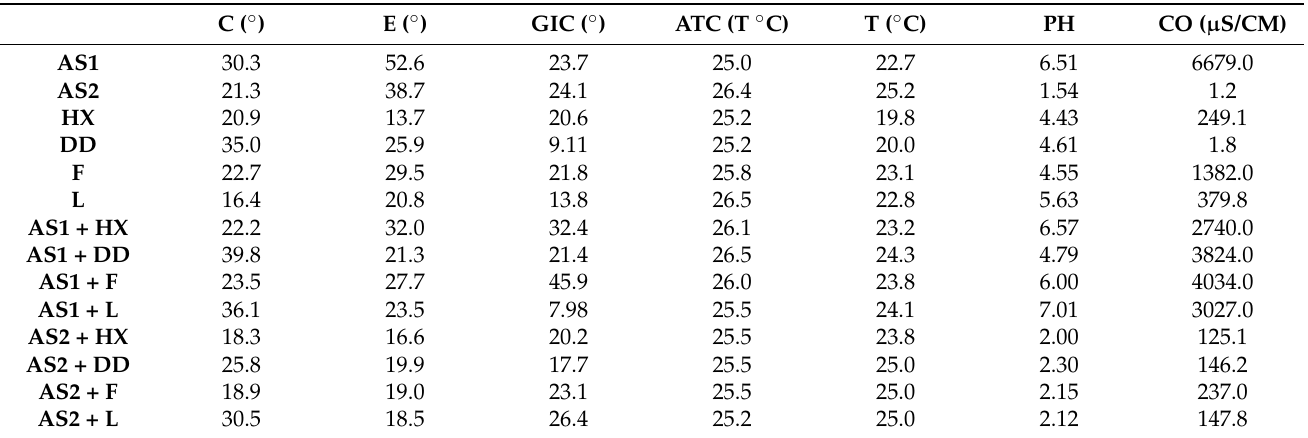
Table 2. Contact angles, automatic temperature compensation within the conductivity measurement canal (ATC), pH, and conductivity of the tested solutions at room